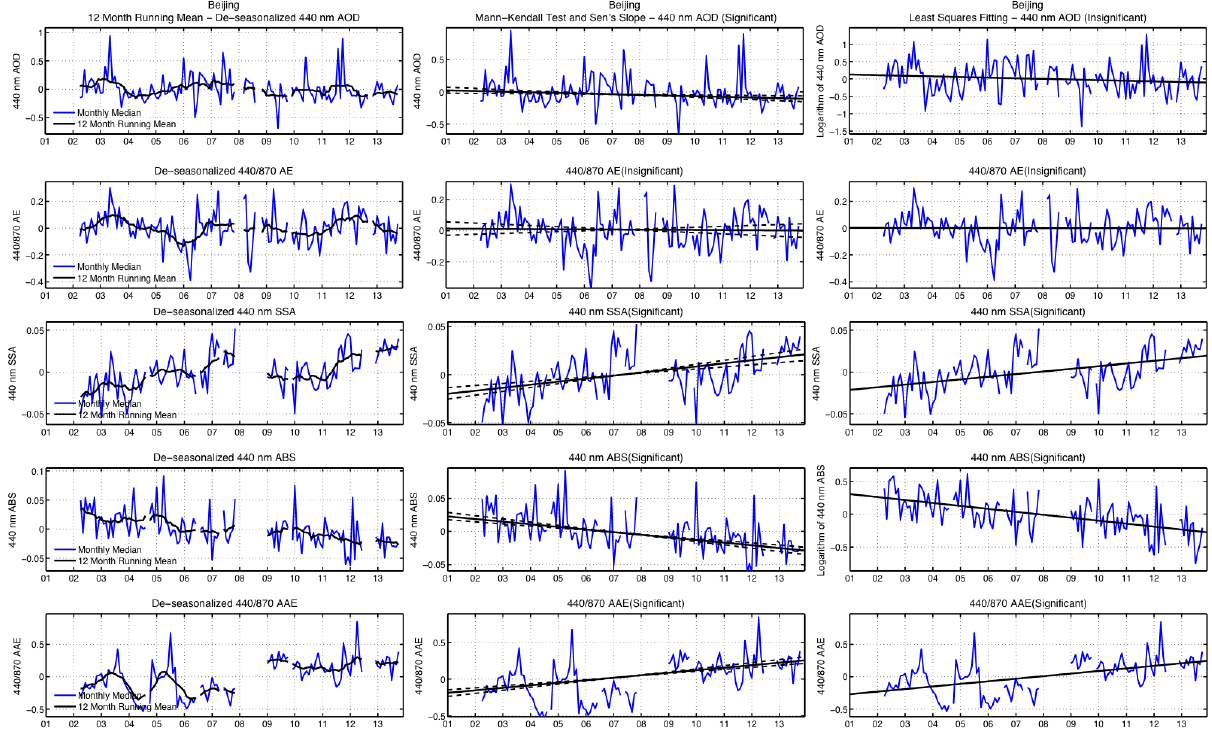
Figure 2. Trend analysis for the six parameters using a 12-month running mean (left column), the Mann–Kendall test associated with Sen’s slope (middle column) and least-squares fitting (right column) for the Beijing station using level 2.0 data. The solid black lines in the MK and least-squares fitting results show the linear trend, and the dashed curves in the middle column indicates the 90% confidence interval of the estimated Sen’s slope.